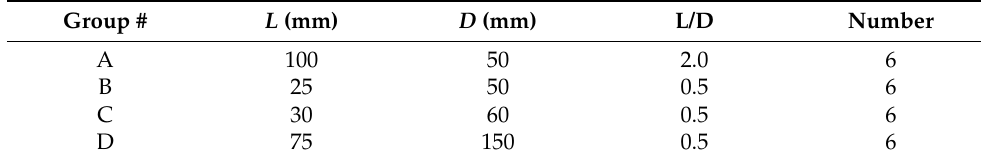
Table 4. Geometry and number of specimens.